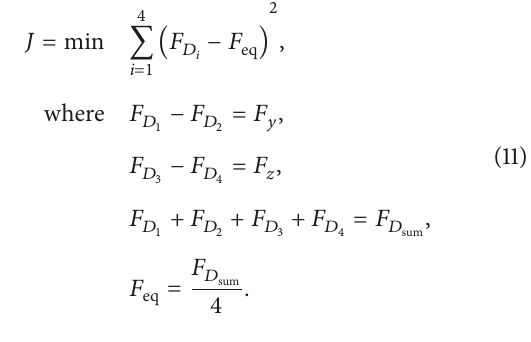
four DCS thrusts can be expressed as a function of one